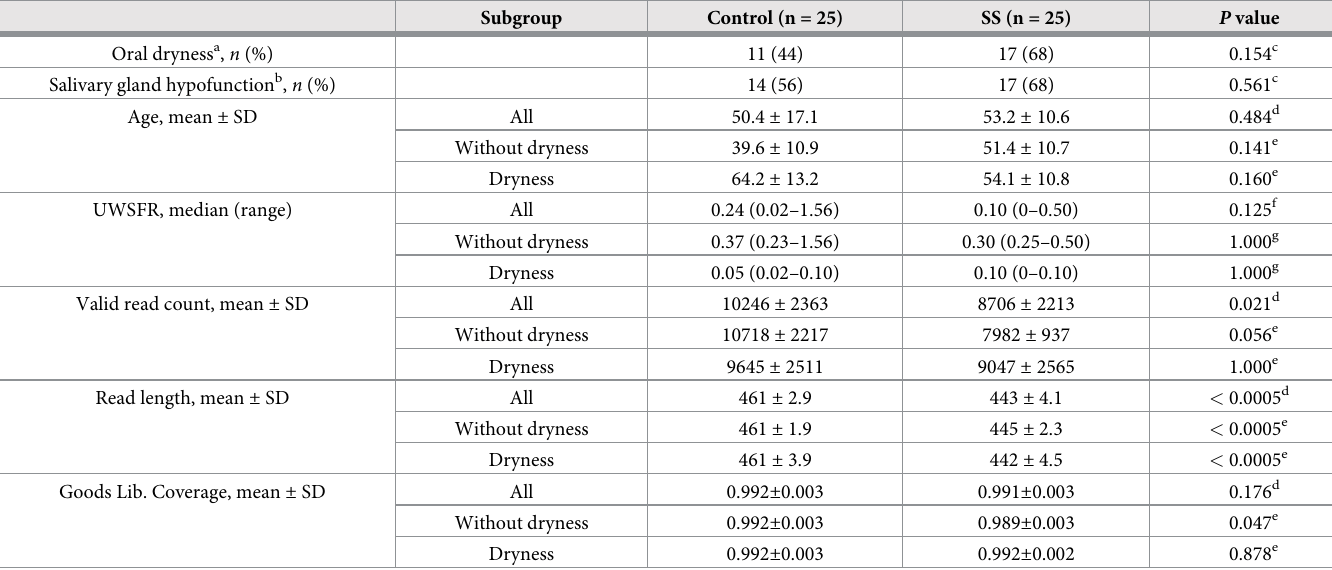
Table 1. Characteristics of the subjects used for oral microbiota analysis and sequencing